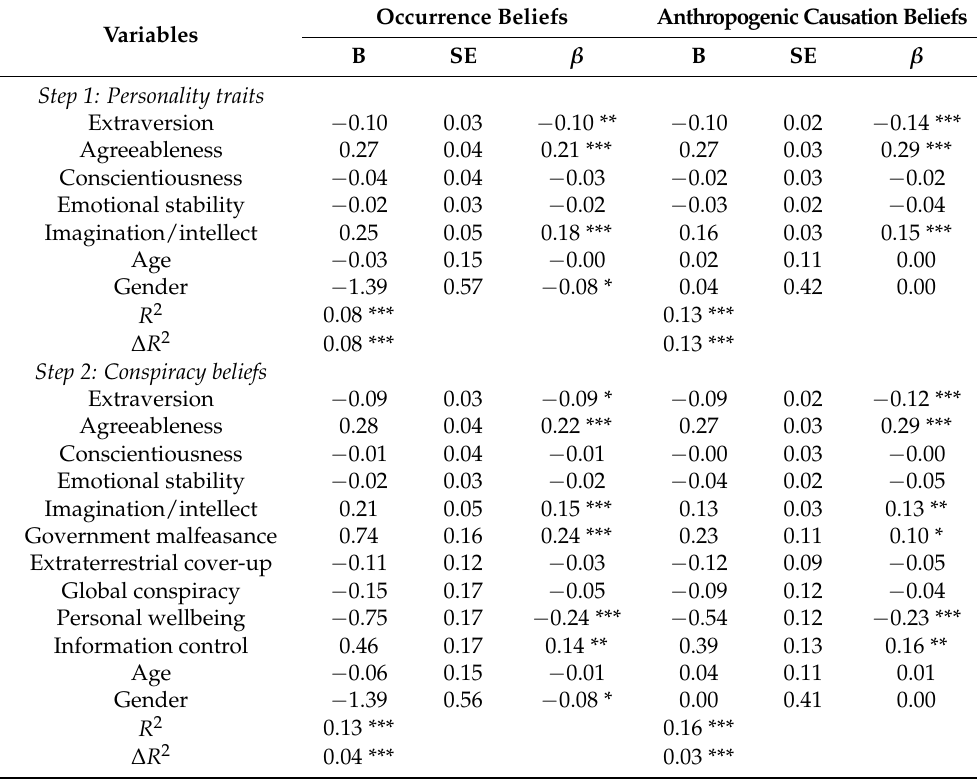
Table 3. Hierarchical linear regression analysis for climate change beliefs